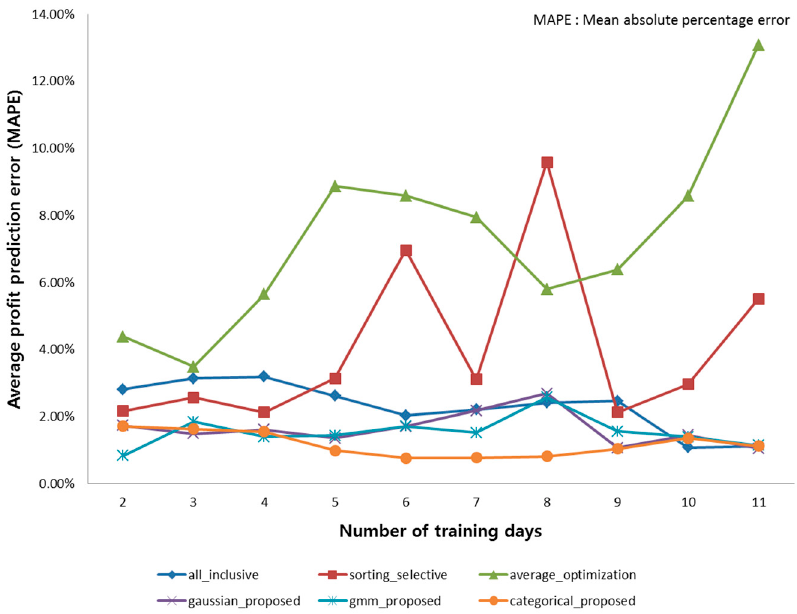
Figure 9. Profit prediction error comparison. The proposed method with categorical distribution provides very low profit prediction error.